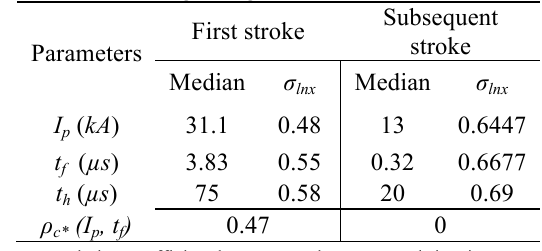
Table 1: Statistical parameters of Multi-stroke Negative Lightning Flashes